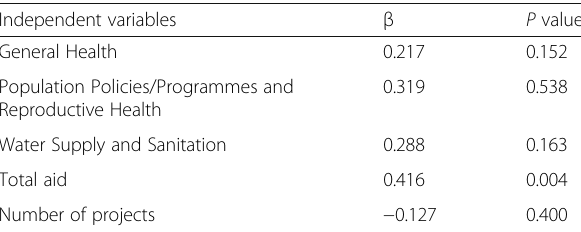
Table 4 The correlation between Chinese exports and specific types of health